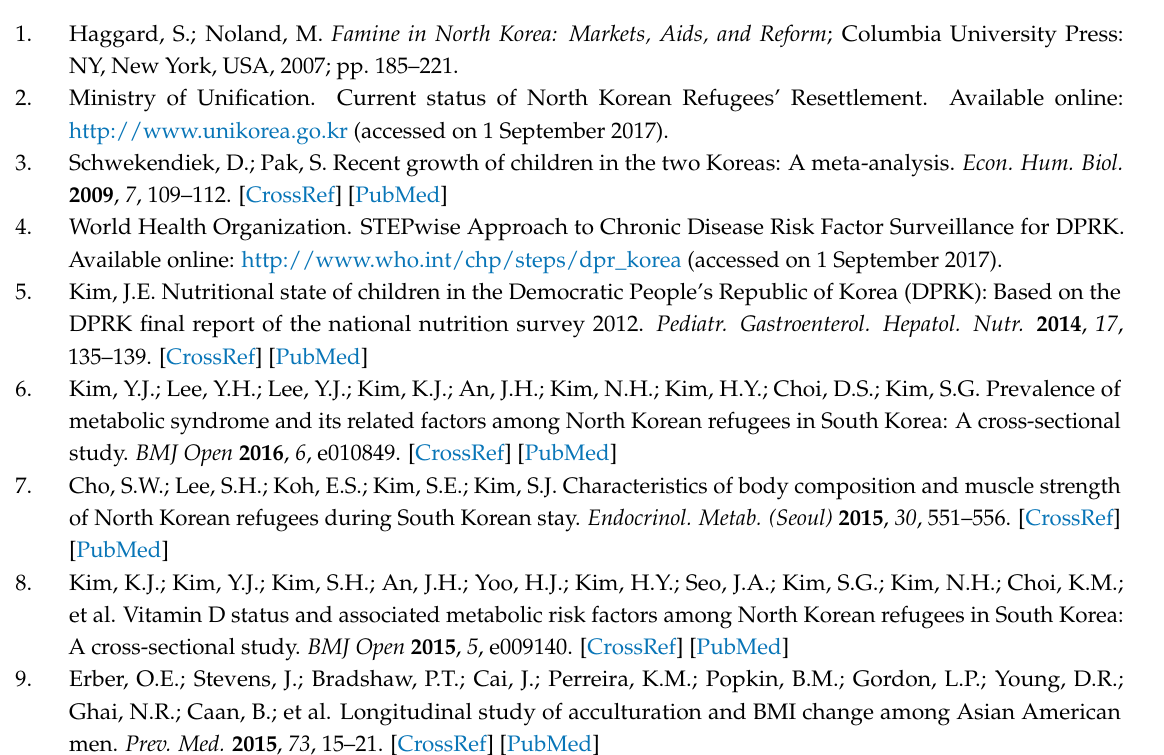
Figure S1: Flow diagram of the study, Table S1: Result of logistic regression analysis on central obesity among NKR females, Table S2: Mean body weight and BMI in North Korea, transit countries and the day on survey among